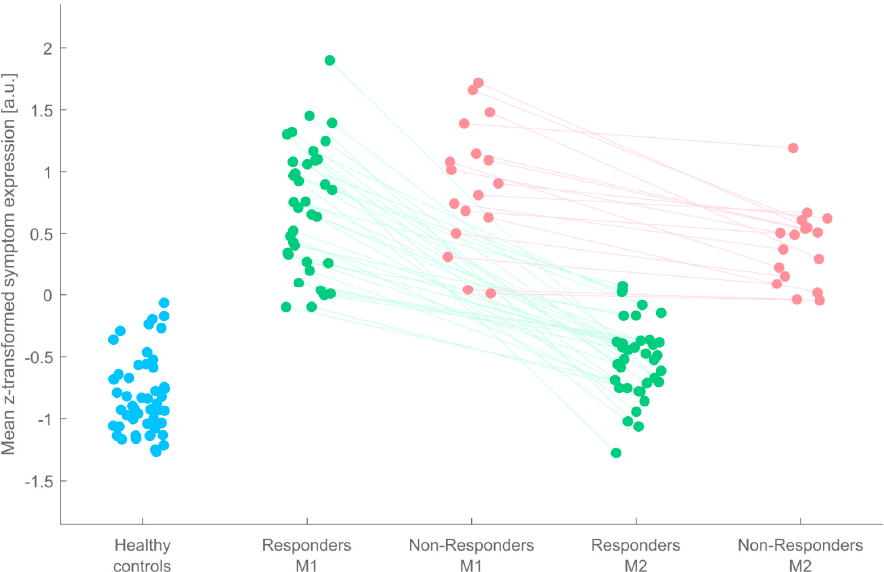
Figure 1. Graphical depiction of machine learning-based classification of adult patients with ADHD who changed back to almost normal levels of individual symptom expression (Responders, green) after 6 weeks of methylphenidate medication and those who did not (Non-Responders, red). The values represent individual mean z-transformed symptom expression, averaged across the 8 feature dimensions, before (M1) and after (M2) treatment with methylphenidate and for healthy controls (blue). Abbreviation: a.u.: arbitrary unit. As machine learning-based classification into subgroups of Responders and Non-Re- sponders does not inform about how group differences are expressed in numerical clinical average rating scores and their changes from M1 to M2, Table S1 summarizes all demo- graphic and clinical variables of interest for both groups separately. We also added clas- sical variance-analytical results from Group-by-Time interaction effects, which permitted to calculate effect sizes for each interaction term.